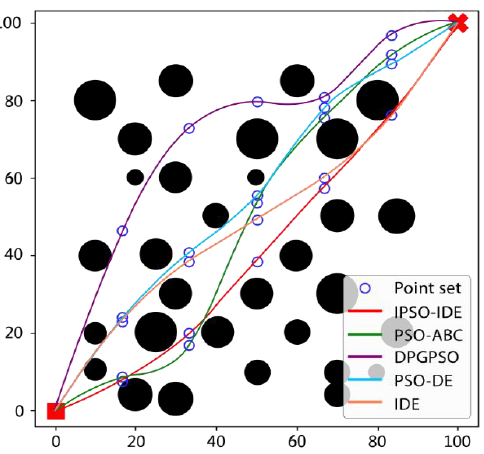
Figure 13. Optimal path results based on different algorithms in environment 4.